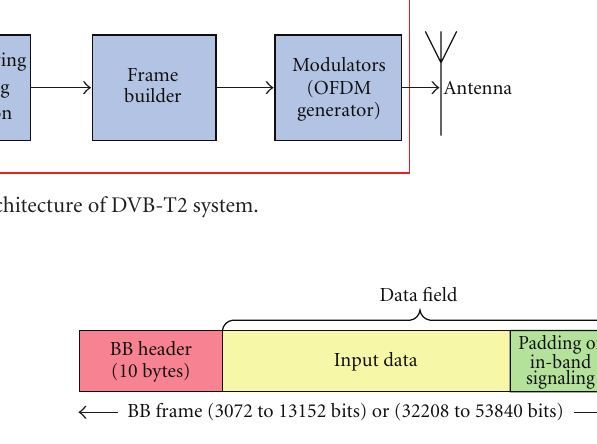
Figure 3: BB frame structure.